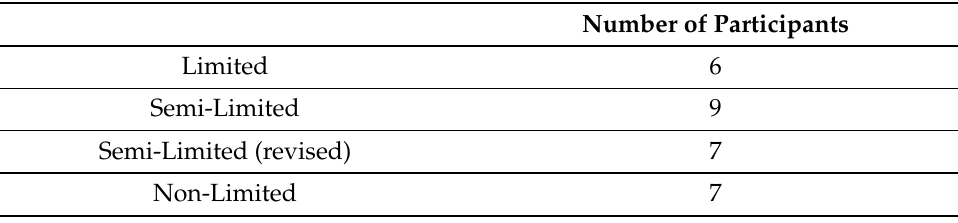
Table 1. The number of participants in different guided mechanisms.